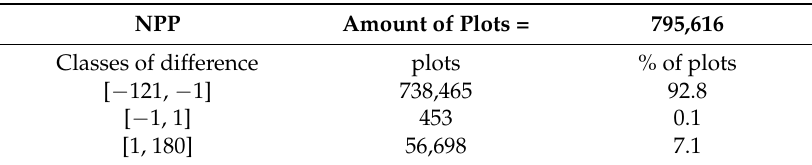
Table 3. Statistics of the potential evolution of the NPP between 2015 and 2050 (NPP is expressed in g/m 2 /year).